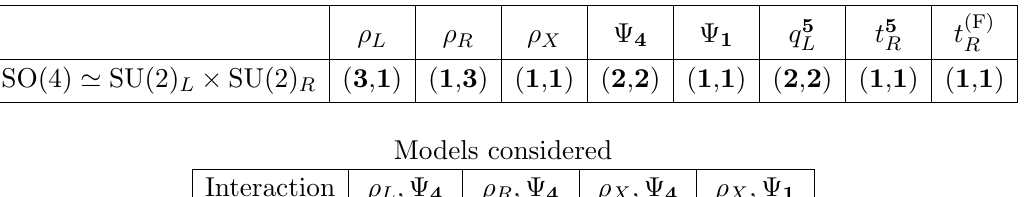
Table 1. Upper table: the particle content considered in this paper and their representations under the unbroken SO(4) ’ SU(2) L (cid:2) SU(2) R . The SM left-handed quarks q L = ( t L ; b L ) T are embedded into an incomplete representation, 5 , of SO(5). We consider two possible origins of the right-handed top quark. It can be partially composite, denoted as t (P) incomplete representation, 5 , of SO(5). It can also be a fully composite resonance, denoted as t (F) and it is assumed to be an SO(4) singlet massless bound state. Their representations under the unbroken SO(4) are also presented in the table. Lower table: the models with di(cid:11)erent combinations of the composite spin-1 resonances (cid:26) and the fermionic resonances (cid:9) considered in our paper. P (F) denotes the partially (fully) composite right-handed top quark.